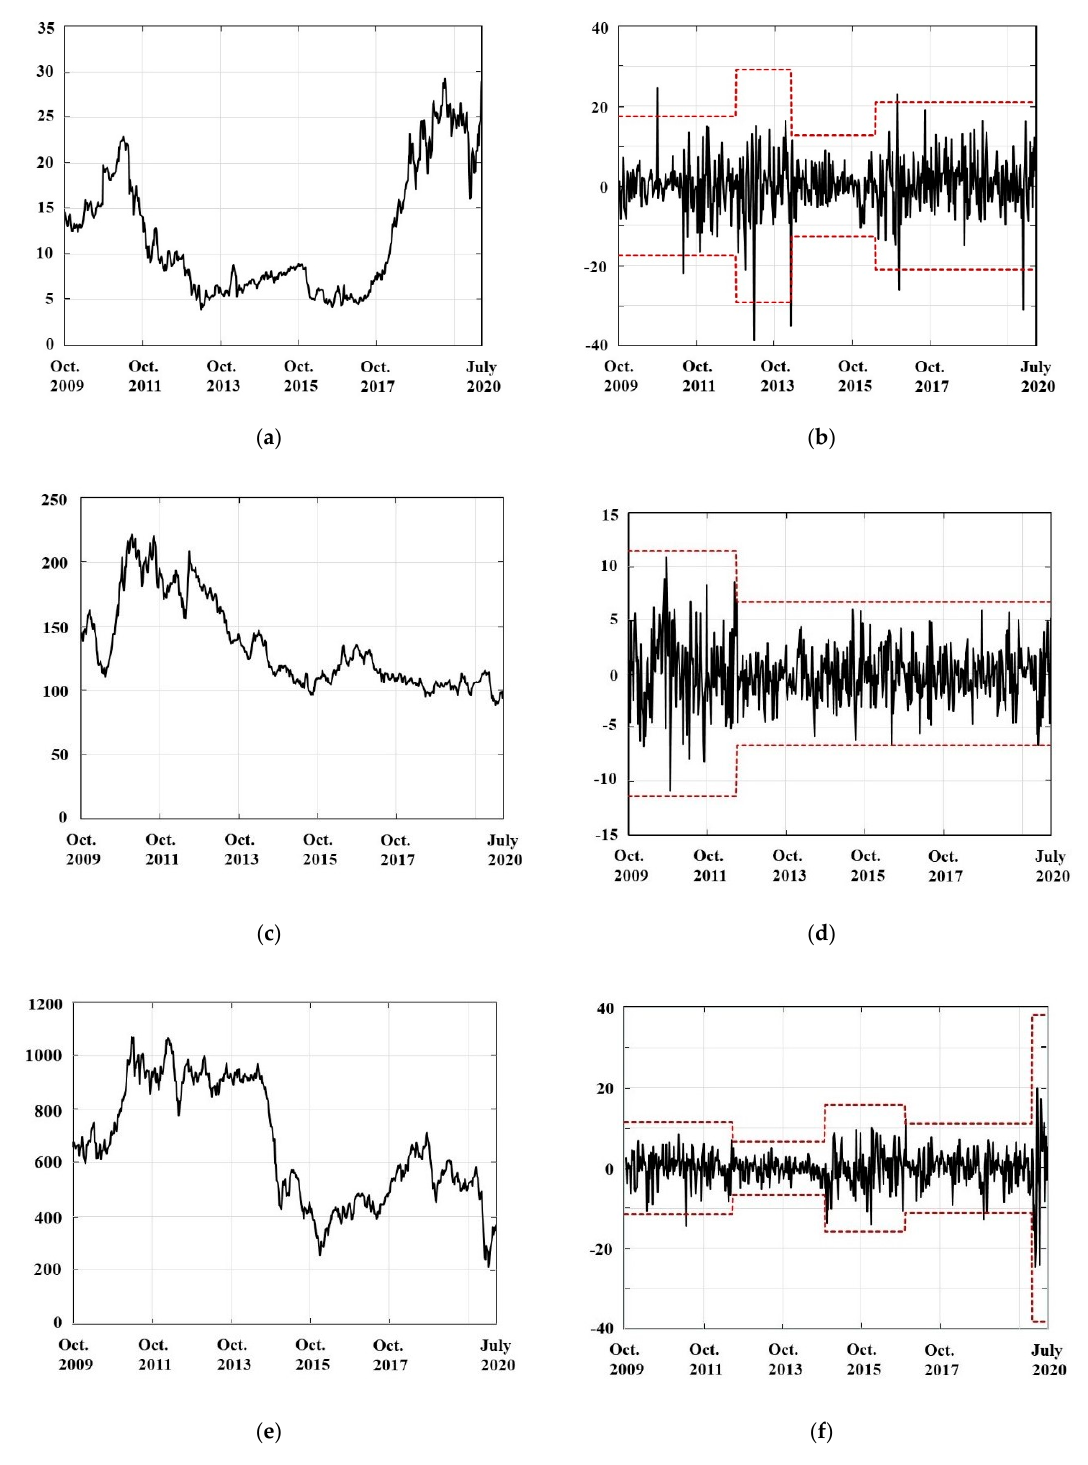
Figure 1. Price dynamics and sudden changes in returns dynamics (Note: The dotted lines define the band of ± 3 standard deviations around the points of sudden changes estimated by the iterative cumulative sum of squares (ICSS) algorithm): ( a ) the EUA price; ( b ) the EUA returns; ( c ) biofuel price; ( d ) biofuel returns; ( e ) Brent oil price; ( f ) Brent oil returns. Panel A of Table 1 introduces the descriptive statistics of the weekly returns for the three markets. During the sample period, the average returns of the EUA are positive, while those of biofuel